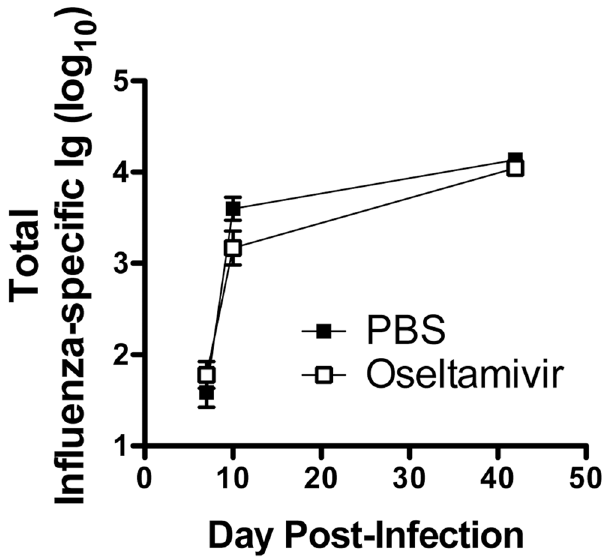
Fig 8. Oseltamivir-treated mice develop normal antibody responses after influenza infection. Mice were treated with PBS or oseltamivir, then infected with X31. At 7, 10 and 42 days post-infection, serum was collected and assessed for total influenza X31-specific antibody by ELISA. Error bars represent standard error of the mean of 5 – 10 mice for each time